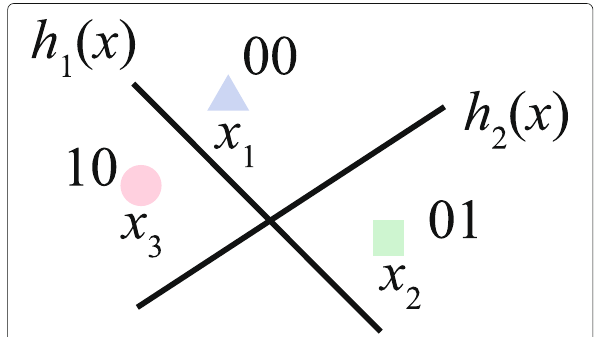
Fig. 1 The hashing functions H = { h 1 ( x ) , h 2 ( x ) } map the data to 2-bit binary code. Without considering the importance of binary bits, x 2 and